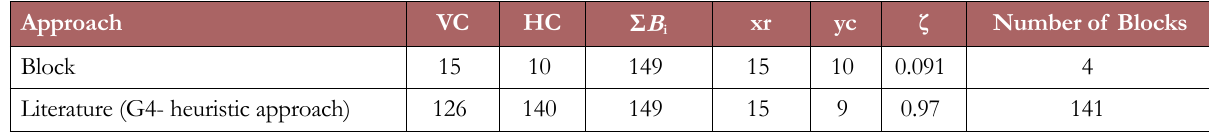
Table 5. Complexity Index for Instance 18